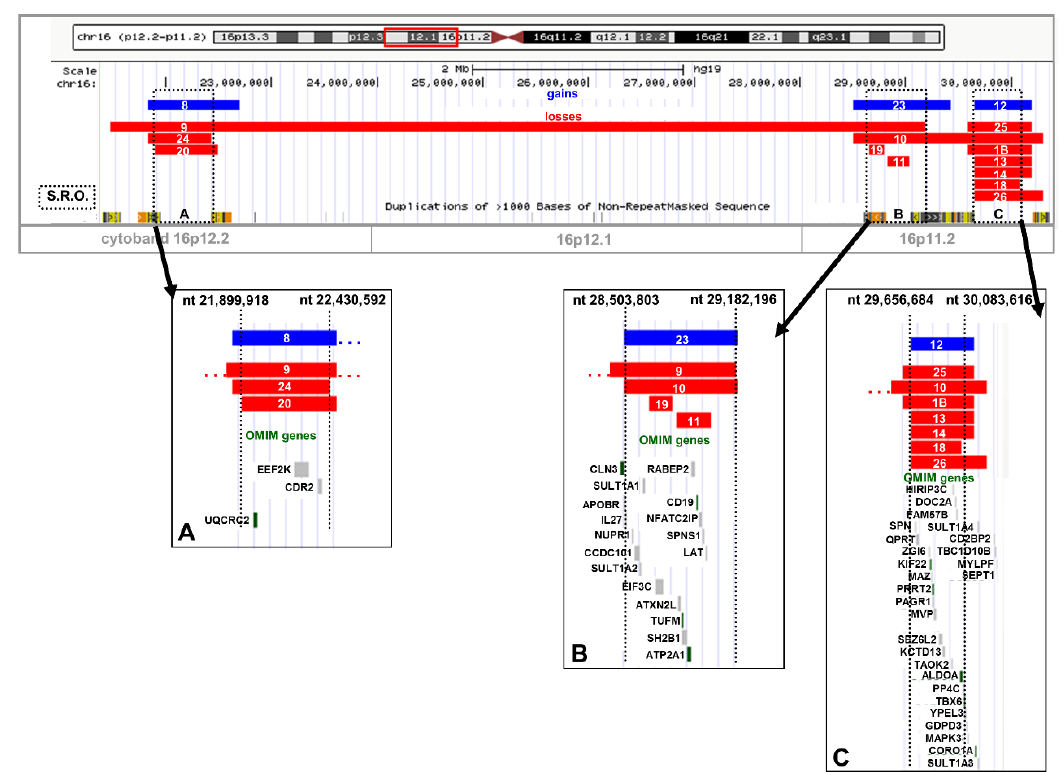
Figure 4. ( A ) 16p12.2 smallest region of overlapping ( B ) 16p11.2 distal smallest region of overlapping ( C ) 16p11.2 proximal smallest region of overlapping. One bar corresponds to one patient and the number refers to the patients reported in Table 1. Red bar indicates a deletion, blue bar a duplication. OMIM genes and segmental duplications are reported.